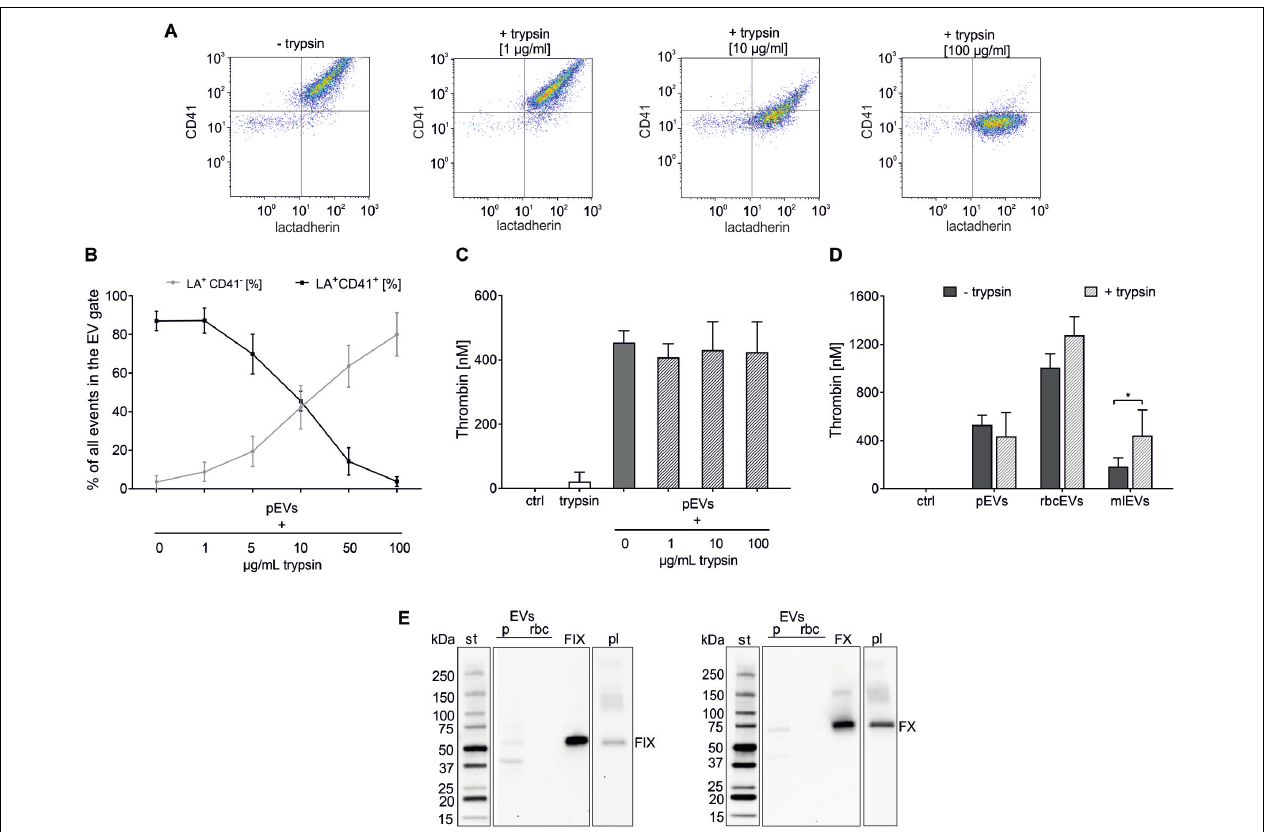
FIGURE 4 | Protease treatment to degrade surface-associated EV proteins. pEVs, rbcEVs, and mlEVs were treated with trypsin to degrade surface-associated proteins as described in the section “Materials and Methods.” (A) Flow cytometry density plots of platelet-derived EVs prior to (–trypsin) and after (+trypsin) protease treatment with increasing trypsin final concentrations (1, 10, 100 µ g/mL), showing the gradual repositioning of the EV cloud from the CD41 + (upper, right) to the CD41 - (lower, right) quadrant. (B) The effect of trypsin treatment was monitored via the decrease of CD41 on the surface of pEVs, which was dose-dependent ( n = 4). Exposure of phosphatidylserine remained unaffected by protease treatment, as shown by flow cytometry after staining with fluorochrome-labeled LA. (C) Thrombin generation induced by pEVs (25 µ g protein/mL) after treatment with 1, 10, and 100 µ g/mL trypsin ( n = 4); trypsin alone was used as control (25 µ g/mL). (D) Thrombin generation induced by pEVs, rbcEVs, and mlEVs with and without trypsin treatment (100 µ g/mL; n = 3), * p < 0.05. (E) Western blotting confirmed the absence of coagulation factors IX and X in blood-cell derived EV fractions (pEVs and rbcEVs). 10 µ g of protein were loaded per well; st, molecular weight standard; FIX, FX, human native factor IX or factor X, 20 ng/lane; pl, EV-depleted citrate plasma diluted 50-fold was used for comparison. The blot images are presented as grouped images from different parts of the same membrane or from different membranes. The original blots are available online as Supplementary Data Sheet S1 of the Supplementary Material